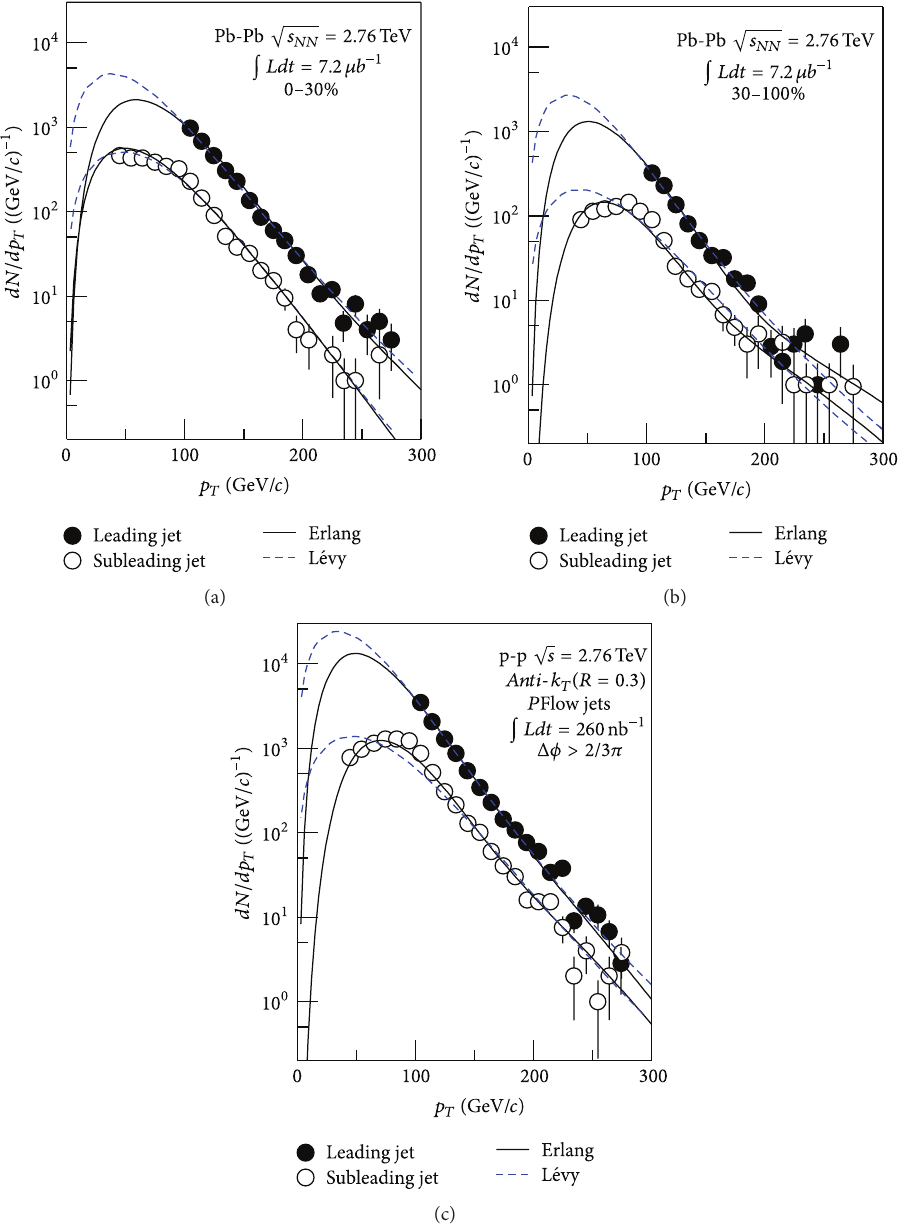
Figure 2: Transverse momentum spectrums of leading and subleading jets produced in Pb-Pb and p-p collisions at √𝑠 𝑁𝑁 or √𝑠 = 2.76 TeV. The symbols represent experimental data of the CMS Collaboration [13]. The solid and dashed curves represent results calculated by the multicomponent Erlang distribution and the L´evy distribution, respectively, (a), (b), and (c) correspond to different selected